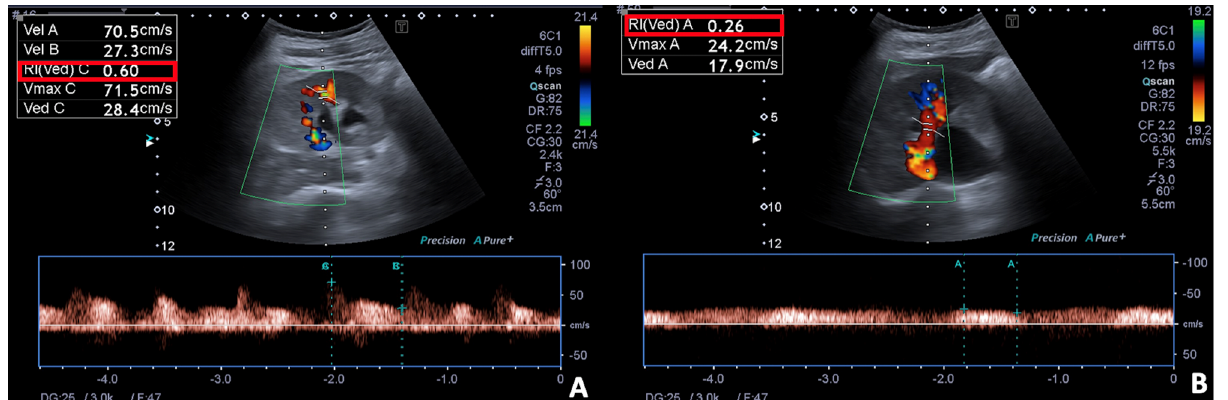
Figure 7. Spectral Doppler and Colour Doppler scans of the right kidney in a pregnant woman with urinary obstruction. Presence of moderate hydronephrosis without the US detection of a calculus; ( A ) the resistivity index is normal, ( B ) while the venous impedance index is increased. Another finding which may aid in the diagnosis of obstructive dilatation is the assessment of the ureteral jet for at least 1 min. If urinary jet is present on the symptomatic side and symmetrical with the contralateral side, significant obstruction is unlikely, whereas if it is unilaterally altered, even in the contralateral oblique decubitus position to decrease uterus mass effect on the bladder and ureter, complete obstruction is highly probable with a reported sensitivity of 100% and specificity of 91% (Figures 8 and 9) [80]. US may direct show calculi with a sensitivity ranging between 34% and 95% or reveal secondary findings of acute obstruction, such as perinephric fluid or absence of ureteral jet [80]. In most cases, stones are smaller than 5 mm and will pass spontaneously with analgesia, bed rest, and hydration.